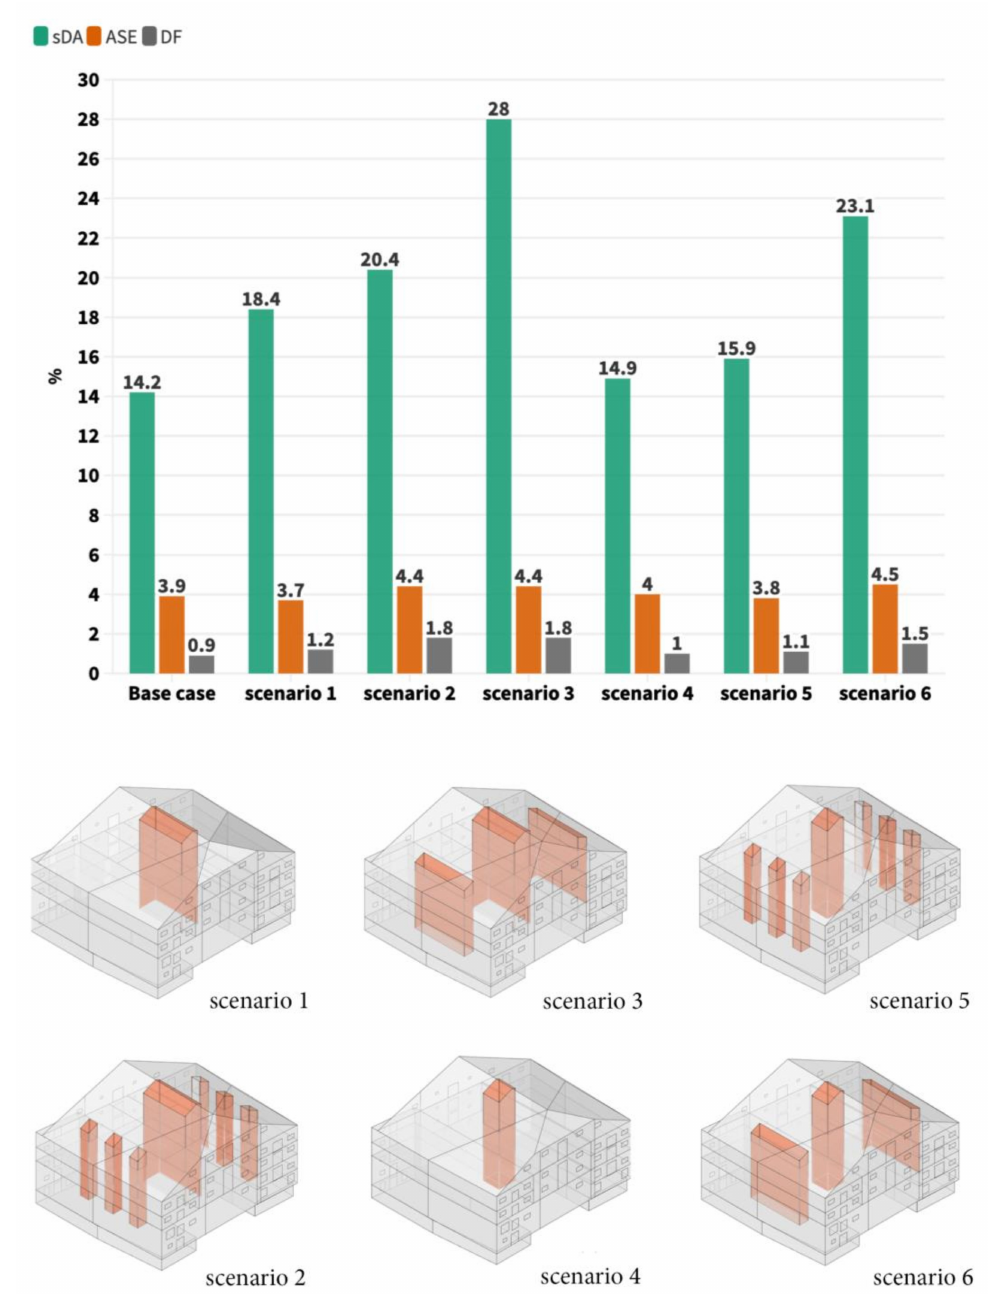
Figure 9. Results of sDA 300,50% , ASE 1000,250 , and DF in the six Scenarios. As for the sDA metric, it was clear that the Scenarios with a united area of the atrium on the top and bottom had more advantages due to larger areas that face the external environment. It can also be noticed that Scenario 4 had the lowest sDA and DF values compared to the other Scenarios (absolute difference = 14.9% and 1% less, respectively). Scenarios 3 and 2 performed the best in achieving sDA with values of 28% and 20.4%, respectively. In contrast, DF in Scenarios 4 and 5 was 1% and 1.1%, and the sDA was 14.9% and 15.9%, respectively. These Scenarios yielded similar performances, thus being the worst-case Scenario among the six configurations, being closer to the base-case. In Scenarios 6 and 1, sDA was 23.1% and 18.4%, respectively. However, DF for Scenarios 6 and 1 was 1.5% and 1.2%. This means that these levels were not compliant with the requirement specified in EN 17037 and LEED